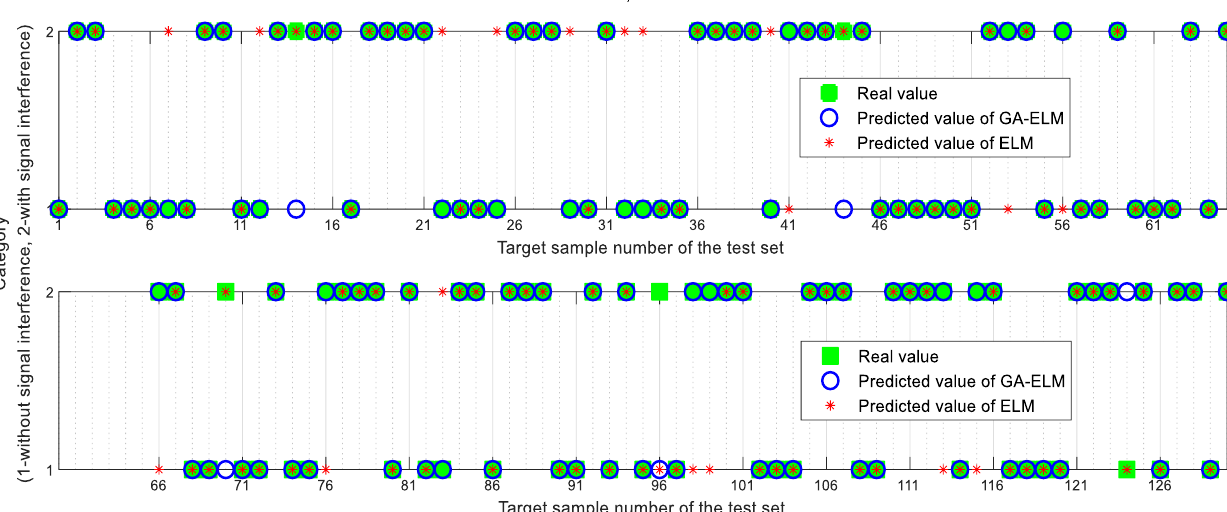
Figure 8. The comparison of the discriminant results of the test set.